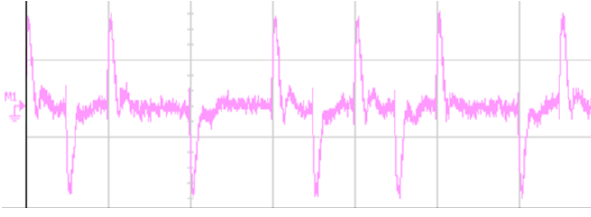
Figure 6. Synchronization signal u 0 (50mV/div.; 500ns/div.)